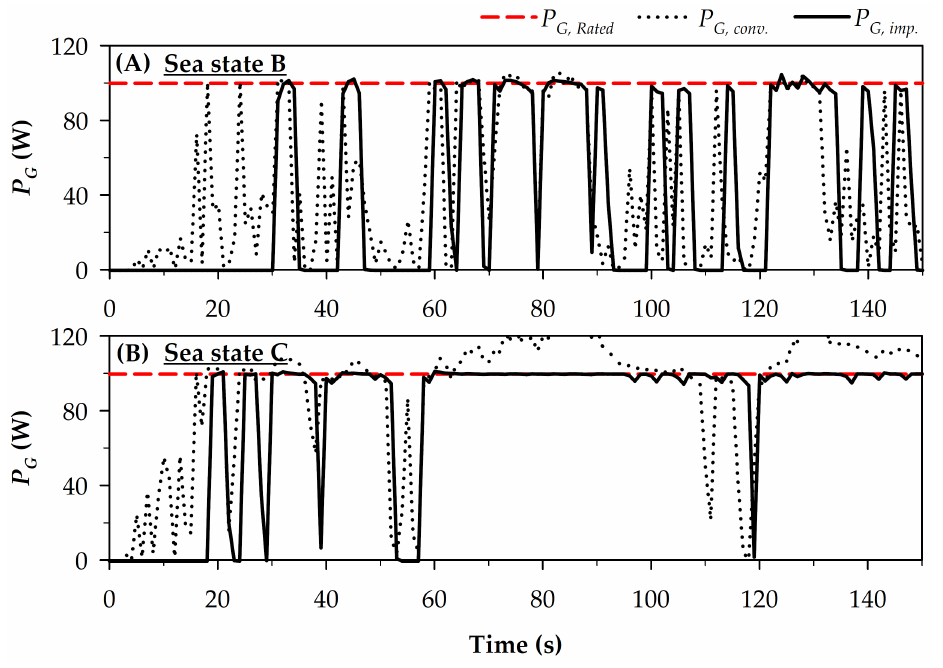
Figure 17. Comparison of the P G , conv . and P G , imp . profiles for the different significant wave height cases.